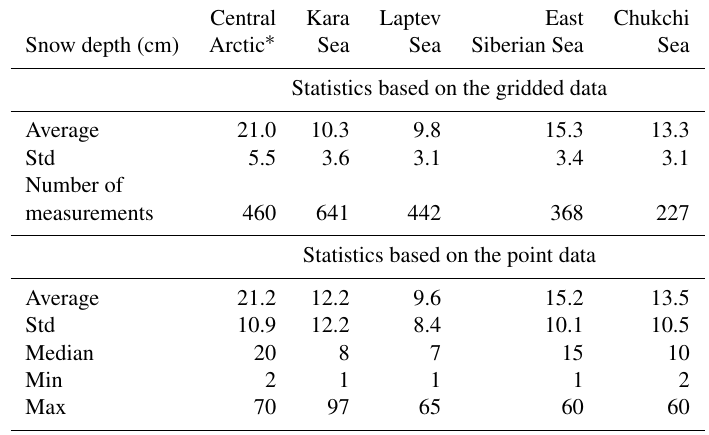
Table 2. Snow depth ( H s ) of undisturbed snow cover on level ice in the landing areas in different parts of the Arctic Ocean for the months March, April and May. Central Kara Laptev East Snow depth (cm) Arctic ∗ Sea Sea